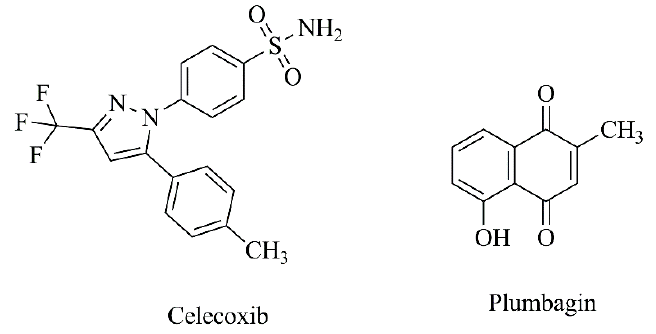
Figure 11. Chemical structures of celecoxib and plumbagin.